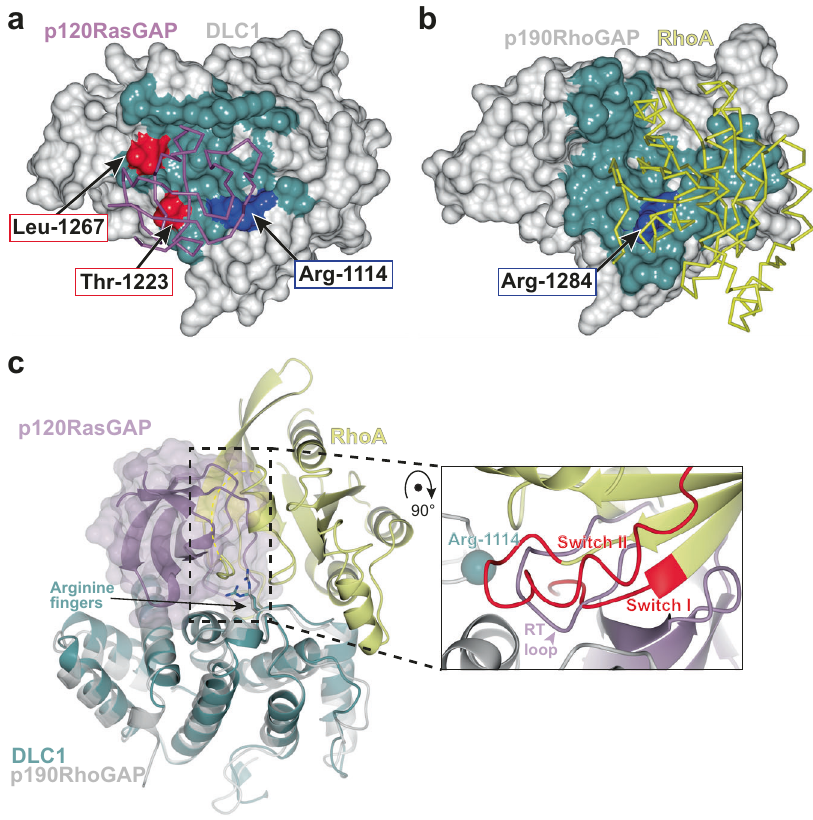
Fig.3|ComparisonoftheRhoGAPbindingsitesforRhoAandp120RasGAPSH3 domain.a SurfaceofDLC1RhoGAPdomainwithp120RasGAPSH3domainbinding site highlighted in blue. The Arginine fi nger Arg-1114 is shown in blue and labeled, and two surface residues mutated in this study (Thr-1223 and Leu-1267) are shown inred. b Surfaceofp190RhoGAPwithRhoAbindingsitehighlightedinteal(PDBID: 5IRC 7 ). The Arginine fi nger Arg-1284 is shown in red and labeled. Views in A and B aresimilaraftersuperpositionoftheRhoGAPdomains.Interfaceresiduesin(A)and (B)arede fi nedbyCCP4mg 84 andisbasedonburiedsurface. c StructureofRhoAin